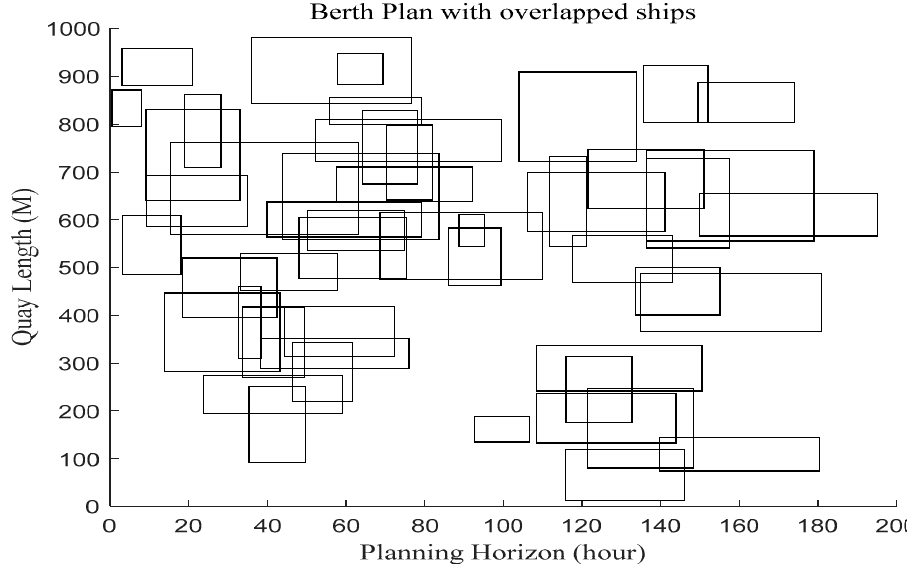
Figure 13. The infeasible berth plan before resolving all overlaps of ships ( N = 50 ships).